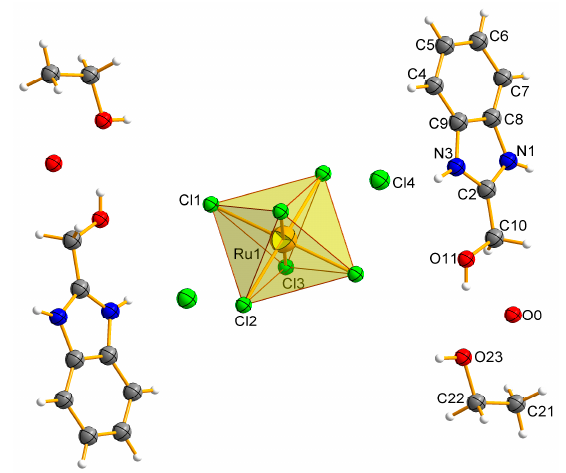
Figure 1. A view part of the (H 3 O) 2 (HL1) 2 [Ru IV Cl 6 ] · 2Cl · 2EtOH structure corresponding to the unit formula and coordination polyhedron of complex 1 .